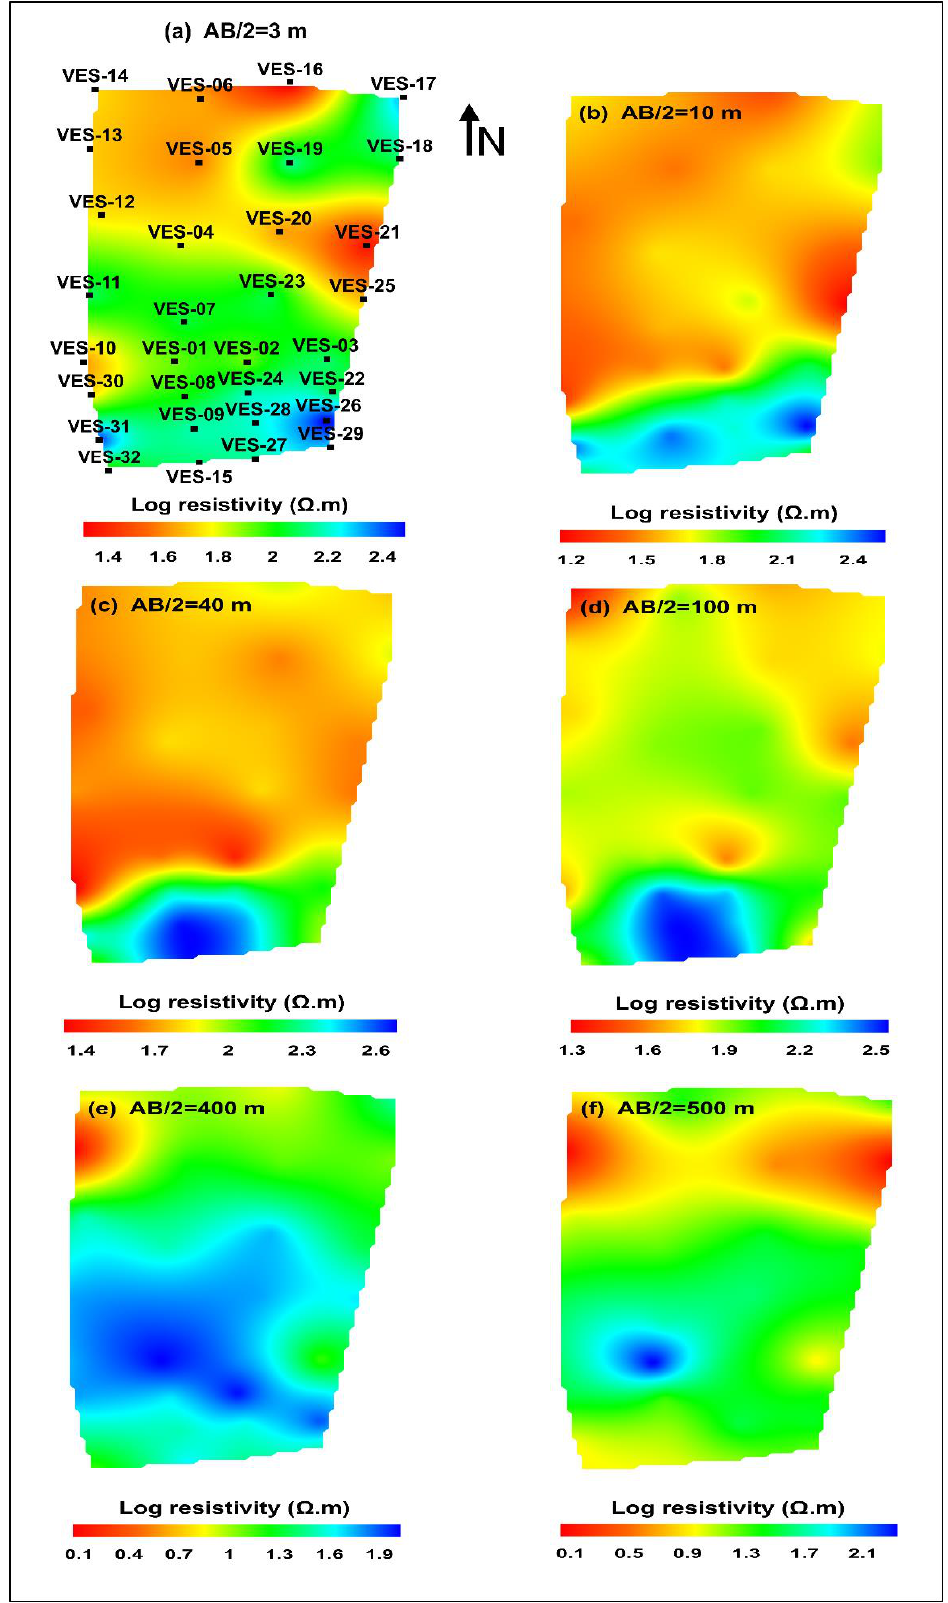
Figure 4. Apparent resistivity maps for different (AB/2) values in the study area. ( a ) AB/2 = 3 m; ( b ) AB/2 = 10 m; ( c ) AB/2 = 40 m; ( d ) AB/2 = 100 m; ( e ) AB/2 = 400 m; ( f ) AB/2 = 500